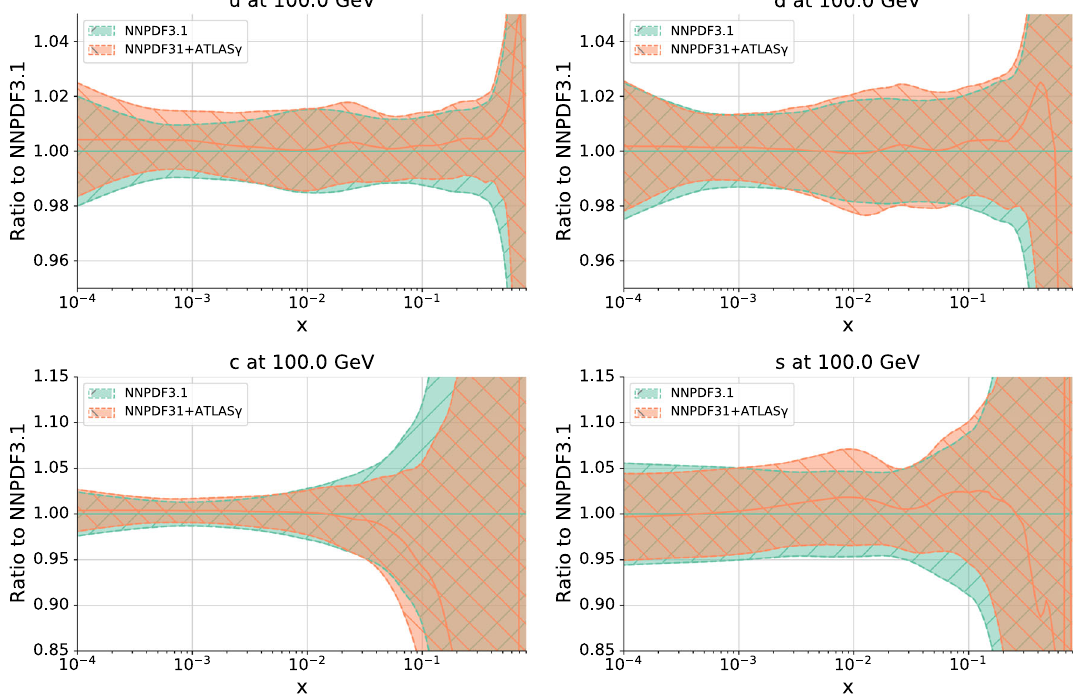
Fig. 7 Comparison of the quark PDFs at Q = 100 GeV between the NNPDF3.1 and NNPDF3.1 + ATLAS γ fits, normalized to the central value of the